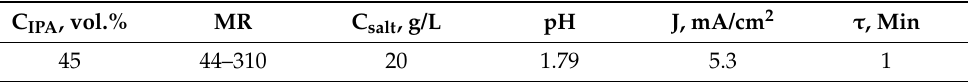
Table 3. The parameters of the reaction medium for determining the MR effect. C IPA ,